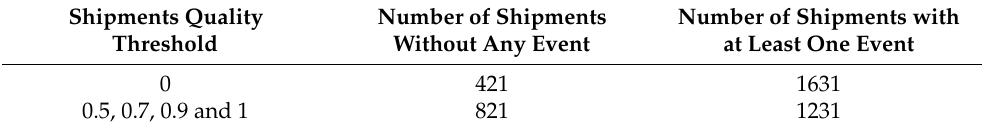
Table 8. Shipments events number evolution.